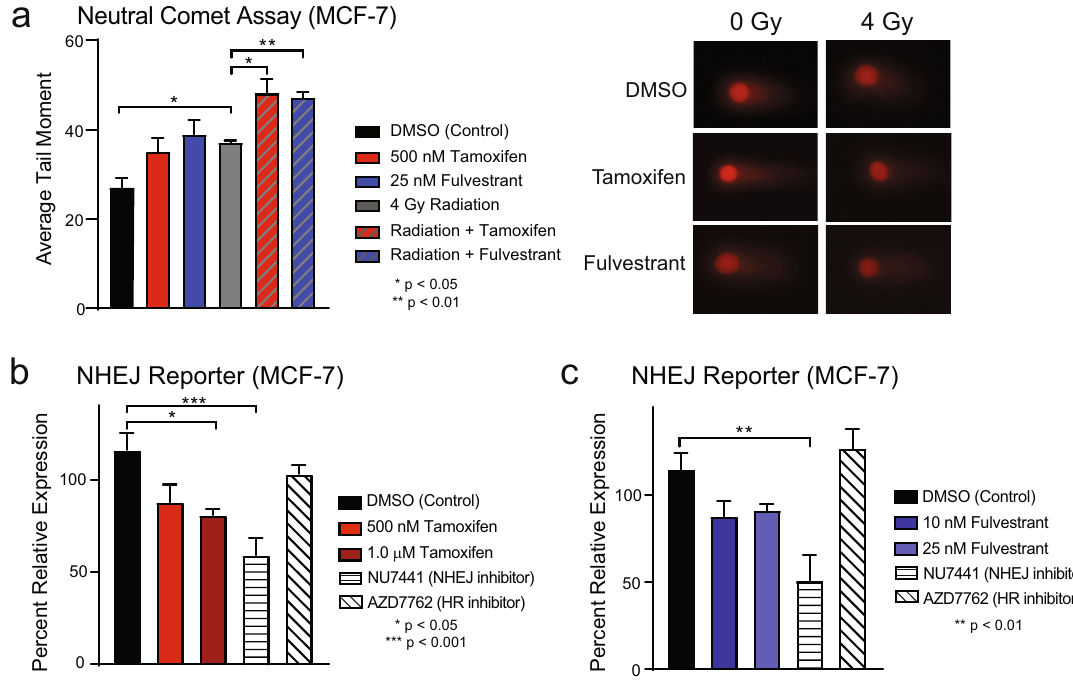
Fig. 2 Tamoxifen inhibits double-strand DNA break repair and NHEJ ef fi ciency in MCF-7 cells. The neutral comet assay was used to assess dsDNA break repair in MCF-7 cells treated with ± 500 n Μ tamoxifen ± 25 nM fulvestrant ± 4 Gy RT ( a ). Representative images of comets are shown. NHEJ ef fi ciency in MCF-7 cells was assessed using a transient pEYFP reporter construct. Cells were treated with tamoxifen ( b ) or fulvestrant ( c ) with AZD7762, a Chk1/2 inhibitor, used as a negative control and NU7441, a DNAPK inhibitor, used as a positive control. Data from triplicate experiments are graphed as mean ± SEM. (* P < 0.05; ** P < 0.01; *** P <